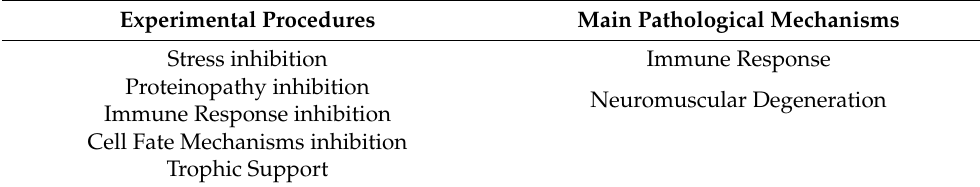
Table 4. Classifications of pathological mechanisms and experimental procedures in